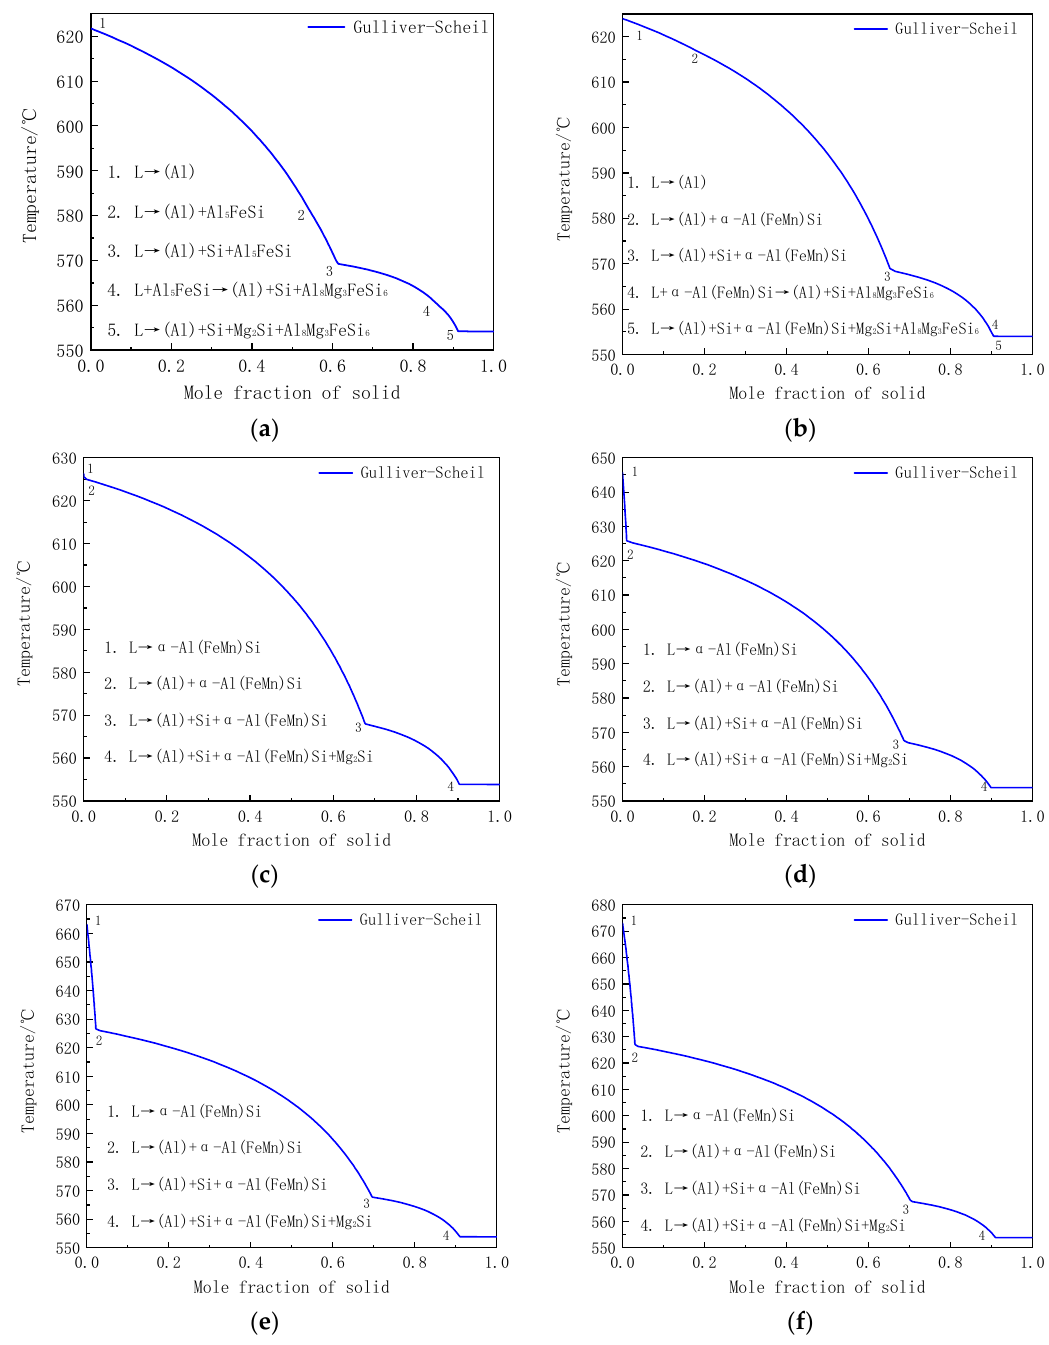
Figure 5. Calculated Solidification curves of Al-5Si-0.8Mg-xMn alloys under Gulliver–Scheil non-equilibrium conditions: ( a ) without Mn and with ( b ) 0.45% Mn, ( c ) 0.72% Mn, ( d ) 1.09% Mn, ( e ) 1.65% Mn and ( f ) 1.97% Mn.